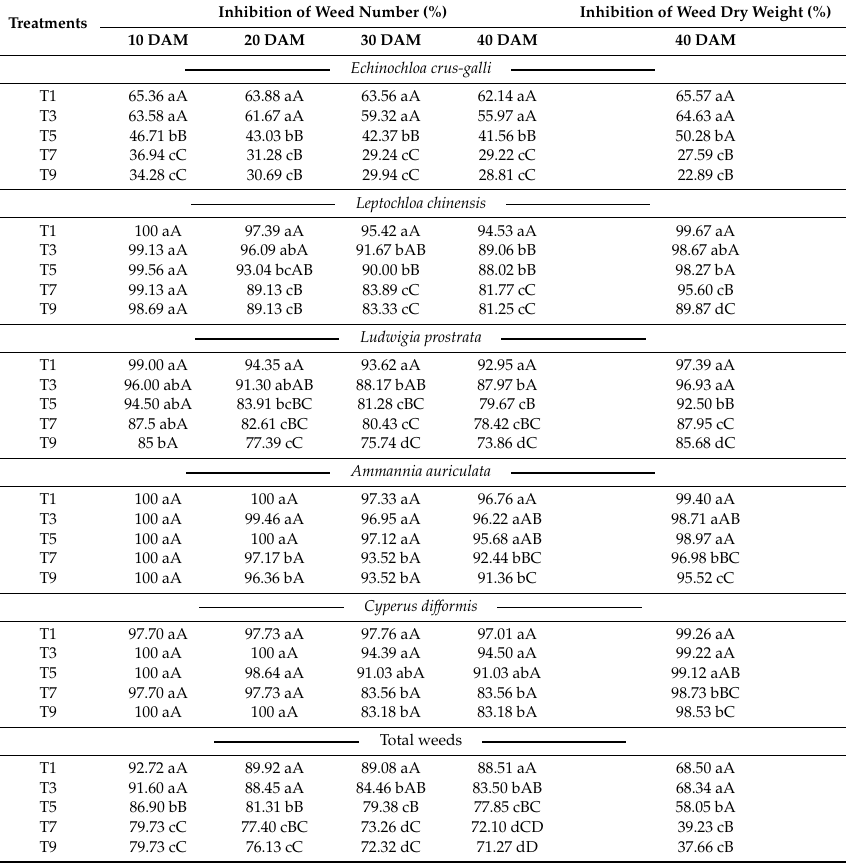
Inhibitory e ff ects of oilseed rape straw mulch on five major weeds in simulated direct-seeded rice. Treatments